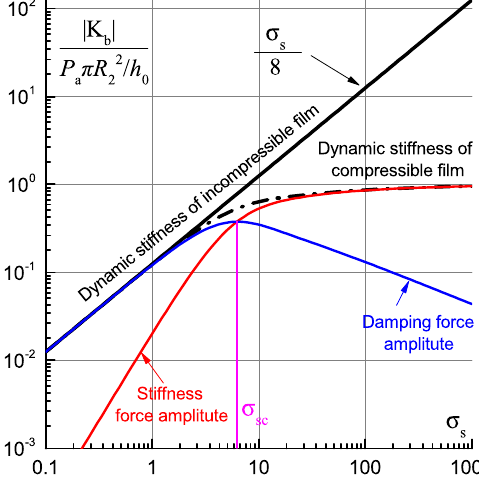
Figure 7. Dynamic stiffness modulus of the 1D parallel disc. Table 2. Parameters of a typical aerostatic thrust